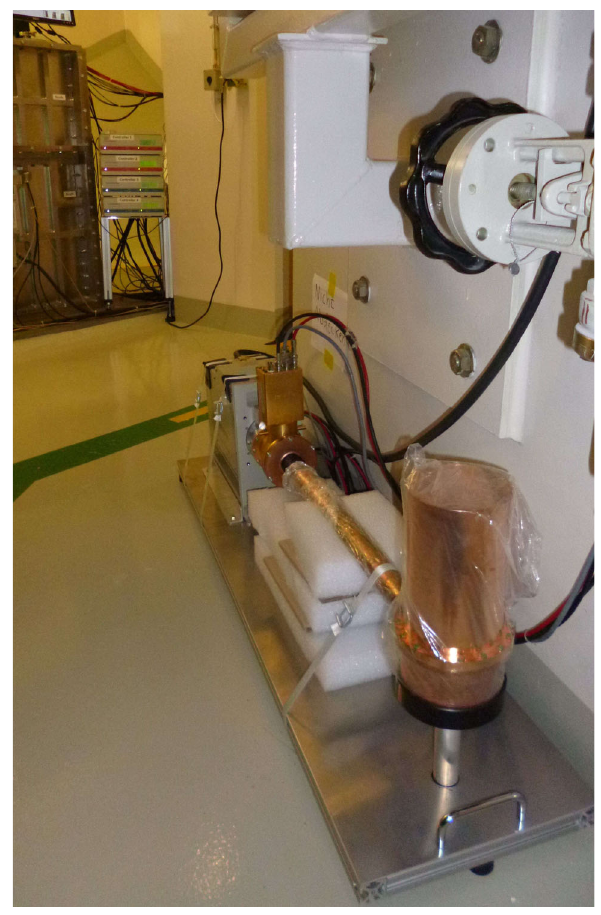
Fig. 20 CONRAD detector at room A408 of KBR. The Cu cryostat with the HPGe diode has been placed near the closest wall to the reactor